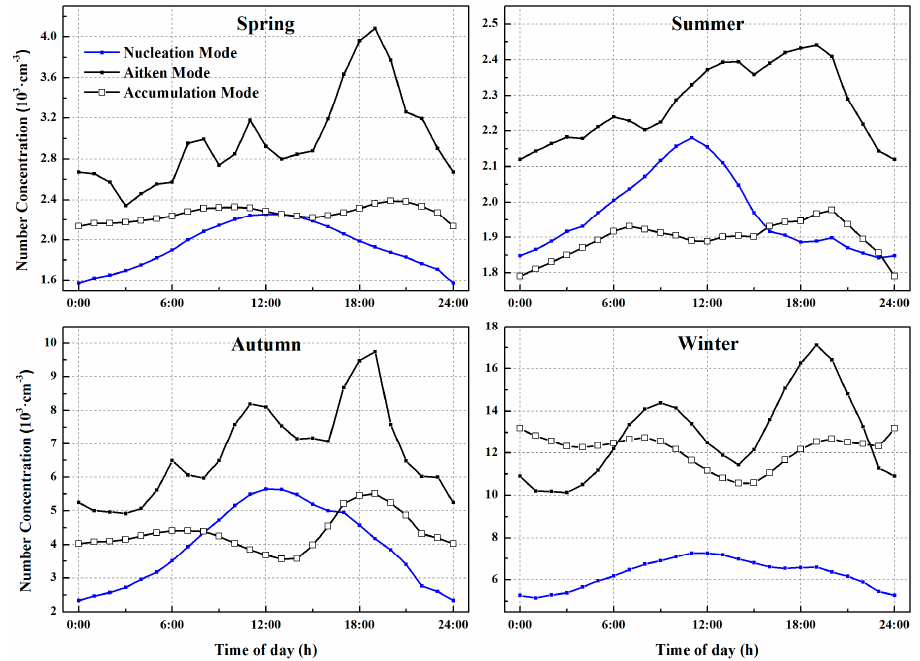
Figure 4. Diurnal variations in averaged particle number concentrations in the nucleation, Aitken, and accumulation modes during the four